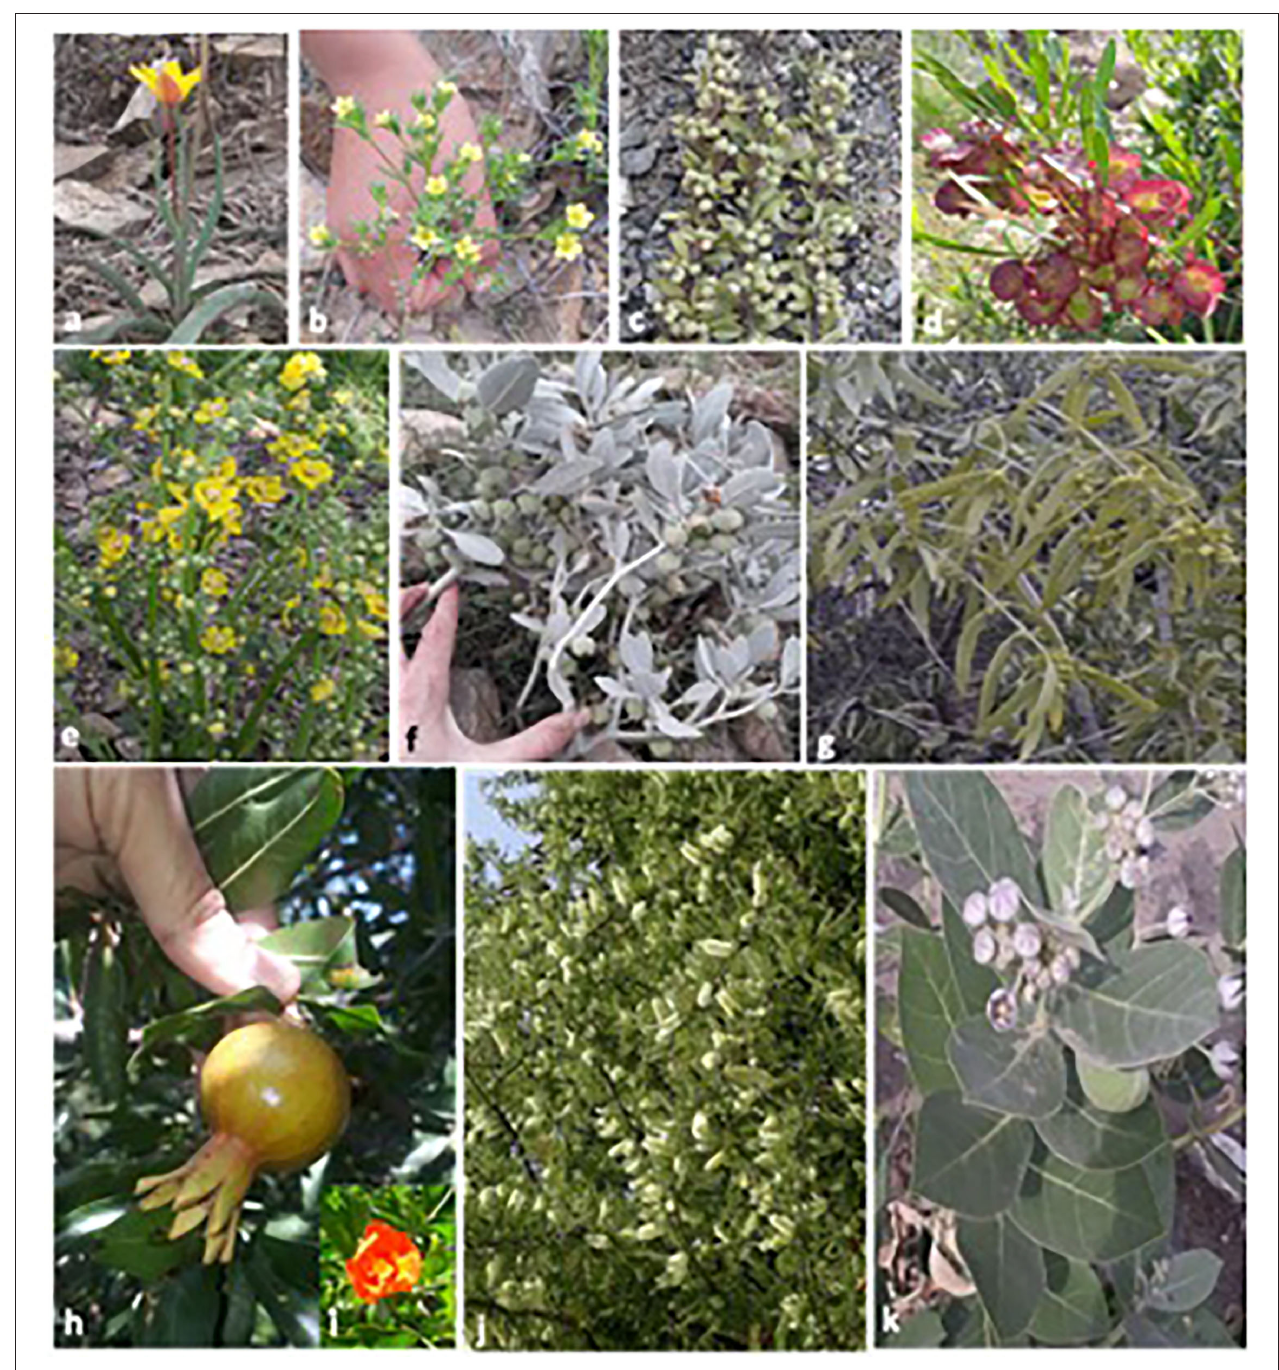
FIGURE 2 | Photographs of some ethnoveterinary medicinal plant species of the study